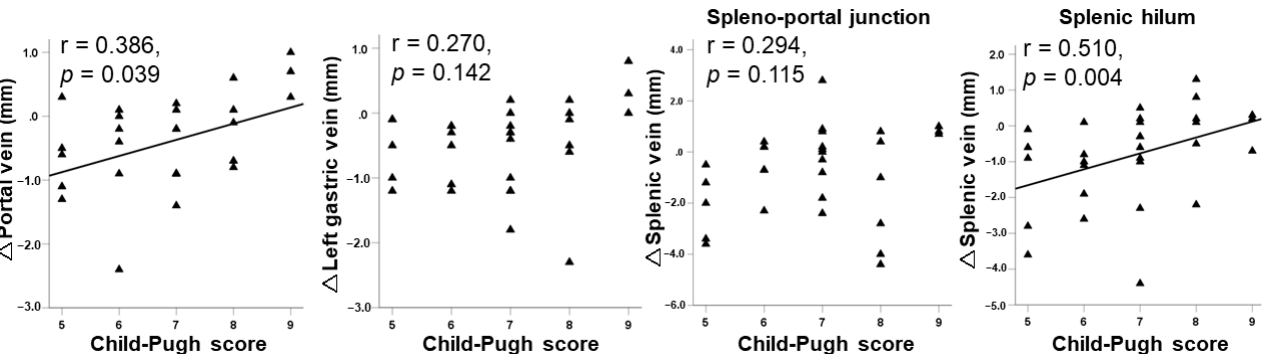
Figure 3. Radiological changes before and after partial spleen embolization. Figure 3 . Radiological changes before and after partial spleen embolization.